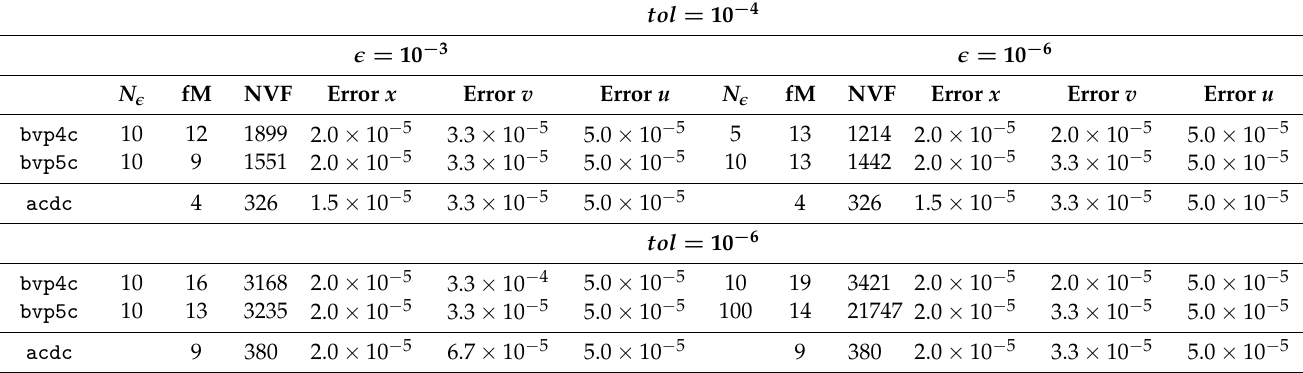
Table 13. Bang-Bang optimal control problem-solving (8) using a piecewise quadratic penalty function with σ = 10 − 4 and the continuation strategy: final mesh (fM), total number of vectorized function evaluation (NVF) and mixed errors for x , v , u